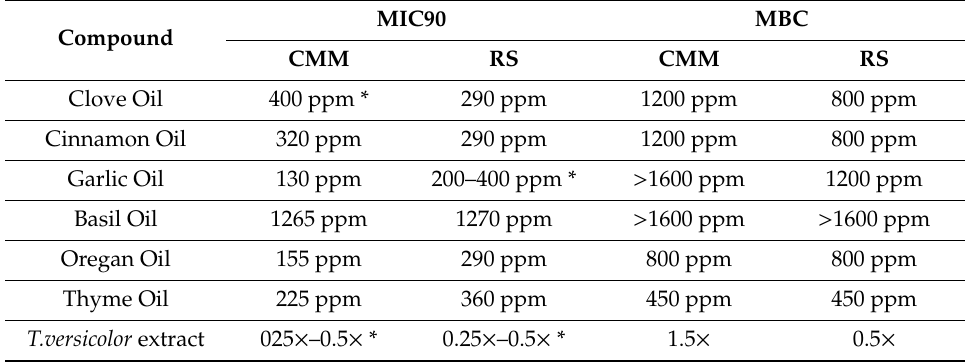
Table 1. MIC90 (minimum inhibitory concentration causing a 90% growth inhibition) and MBC (minimum bactericidal concentration values calculated for each couple compound /